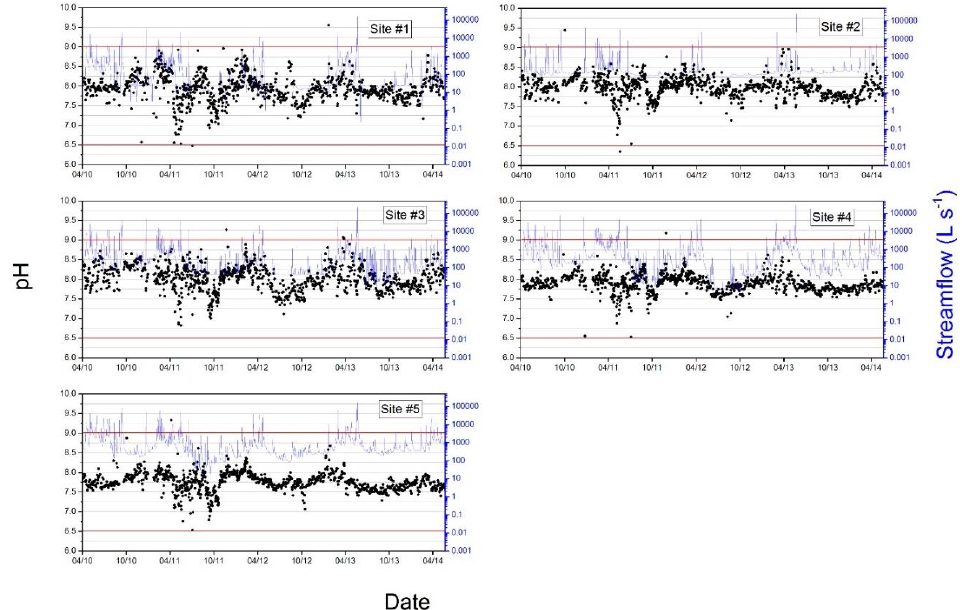
Figure 5. pH and streamflow (L s − 1 ) at each gauging site ( n = 5) during study period (October 2010–May 2014) in Hinkson Creek Watershed, MO, USA. Red lines depict minimum and maximum thresholds established by Missouri Department of Natural